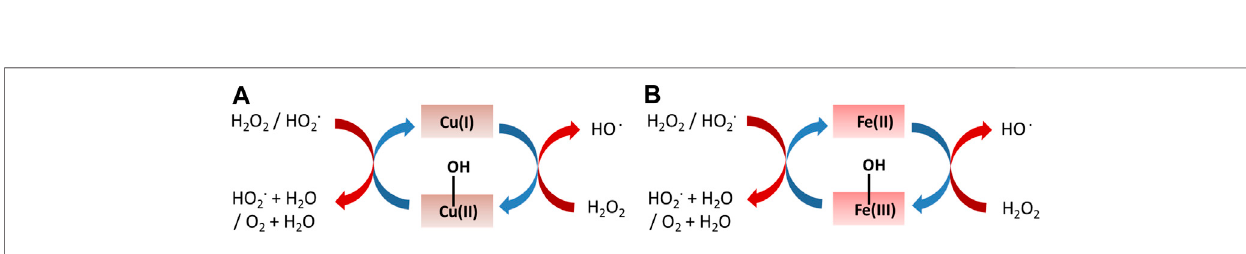
FIGURE 6 | Mechanism of reductive energy storage of TiO 2 -WO 2 photocatalyst (Wang et al., 2012).